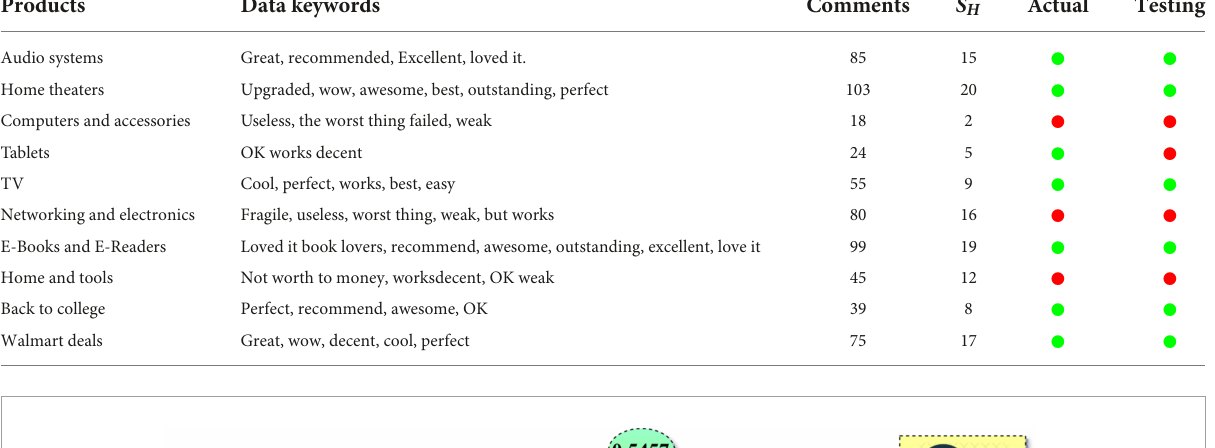
TABLE 2 Prioritization process from the input dataset.